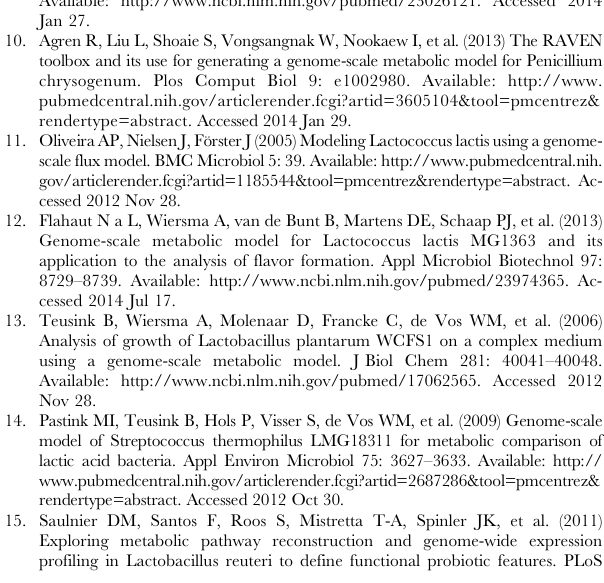
Table S1 Comparison of essential amino acids (listed as E) determined from experiments among lactic acid bacteria, for which metabolic models have been built. Table S2 Compounds allowed to be taken up during flux balance analysis in both L. casei models. Flux represents uptake rate, units are mmol/gDW/h. Table S3 Type of gene deletion sets, with glucose or galactose with essential amino acids condition, found in